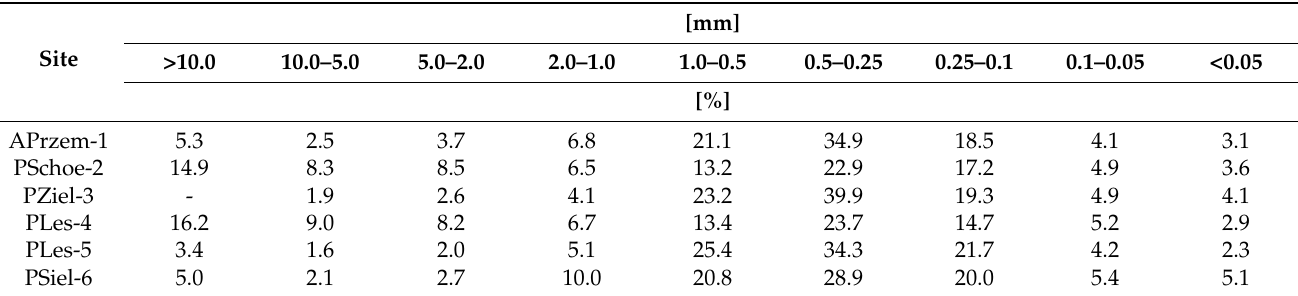
Table 2. Granulometric composition in the analysed sites.